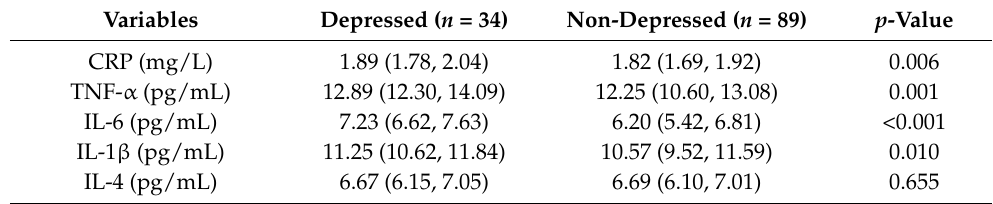
Table 3. Plasma inflammatory markers in depressed and non-depressed breast cancer patients.